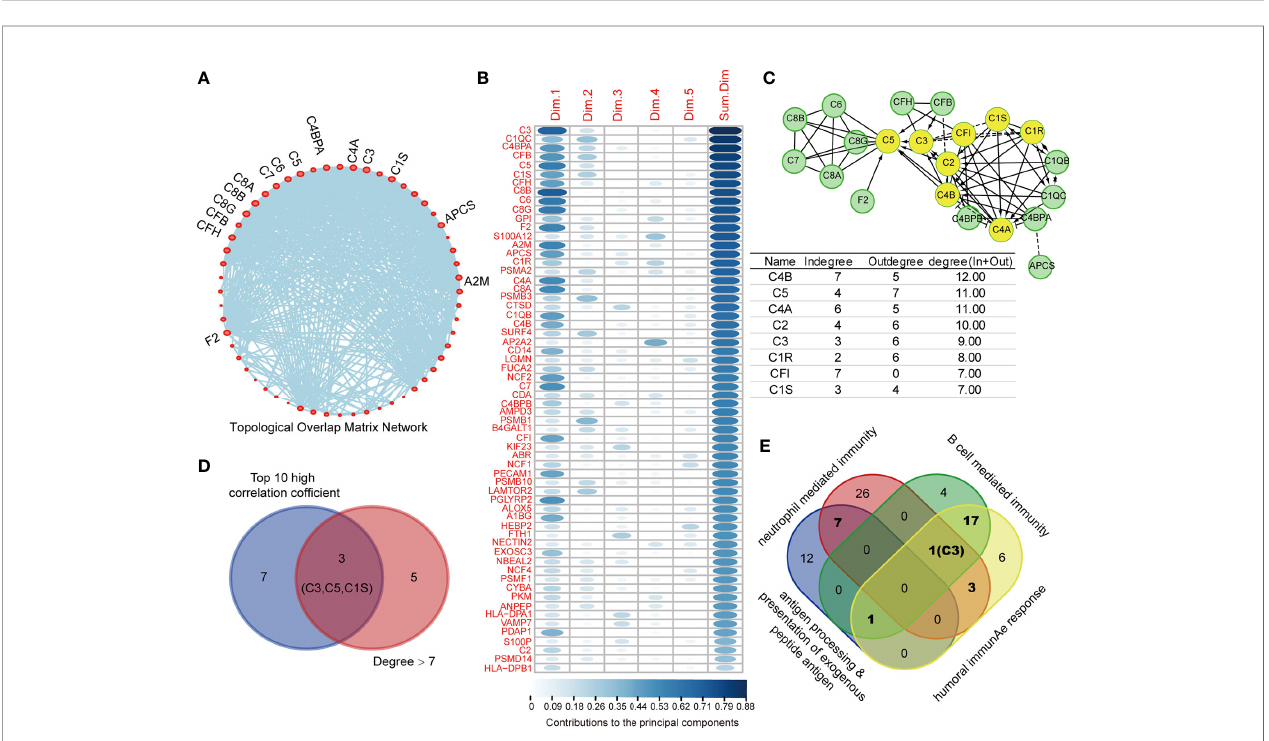
FIGURE 4 | C3 is the core protein in topological overlap matrix (TOM) established by immune-relevant differential expressed proteins (DEPs). (A) 62 out of 77 immune-relevant DEPs were employed to establish the TOM, and those proteins with centrality higher than 30 were highlighted and named in the network. (B) 62 immune relevant DEPs were subjected to principal component analysis (PCA) analysis, the contribution values of individual protein to top fi ve principal component were summarized and ranked. (C) The Protein-Protein Interaction network of the 62 immune-relevant DEPs were plotted by REACTOME (upper). The degrees for each protein in the network were listed (lower). C3, C5, and C1S showed not only degree > 7, but also ranked as the top 10 high correlation coef fi cient proteins (D) . (E) The Venn plot depicting the C3 was the only protein that co-identi fi ed in four immunity related